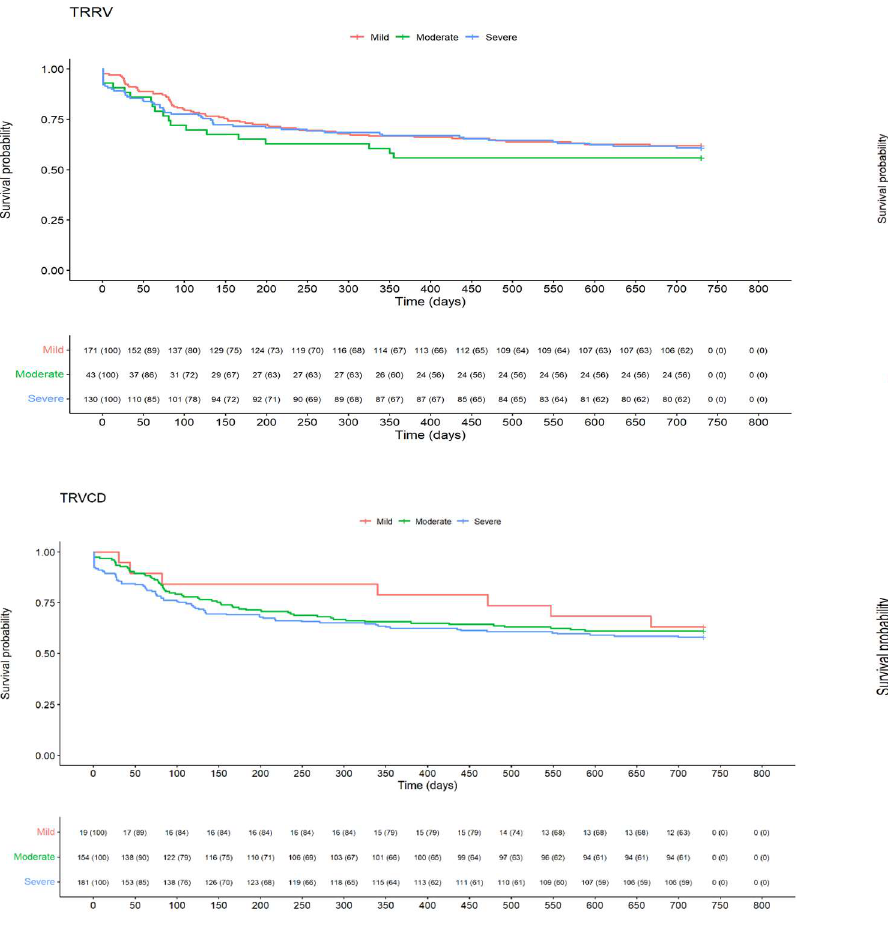
Figure 1. Unstratified Kaplan–Meier curves of 4 different assessment of tricuspid regurgitation (TR) severity and their impact on 2-year all-cause mortality with numbers at risk outlined beneath each panel. Clockwise from top-left: TR regurgitant volume (TRRV), TR effective regurgitant orifice (TRERO), TR vena contract to tricuspid annulus diameter (VC/TA) where curves display population at risk above and below a threshold of 0.24 and TR vena contract diameter (TRVCD).